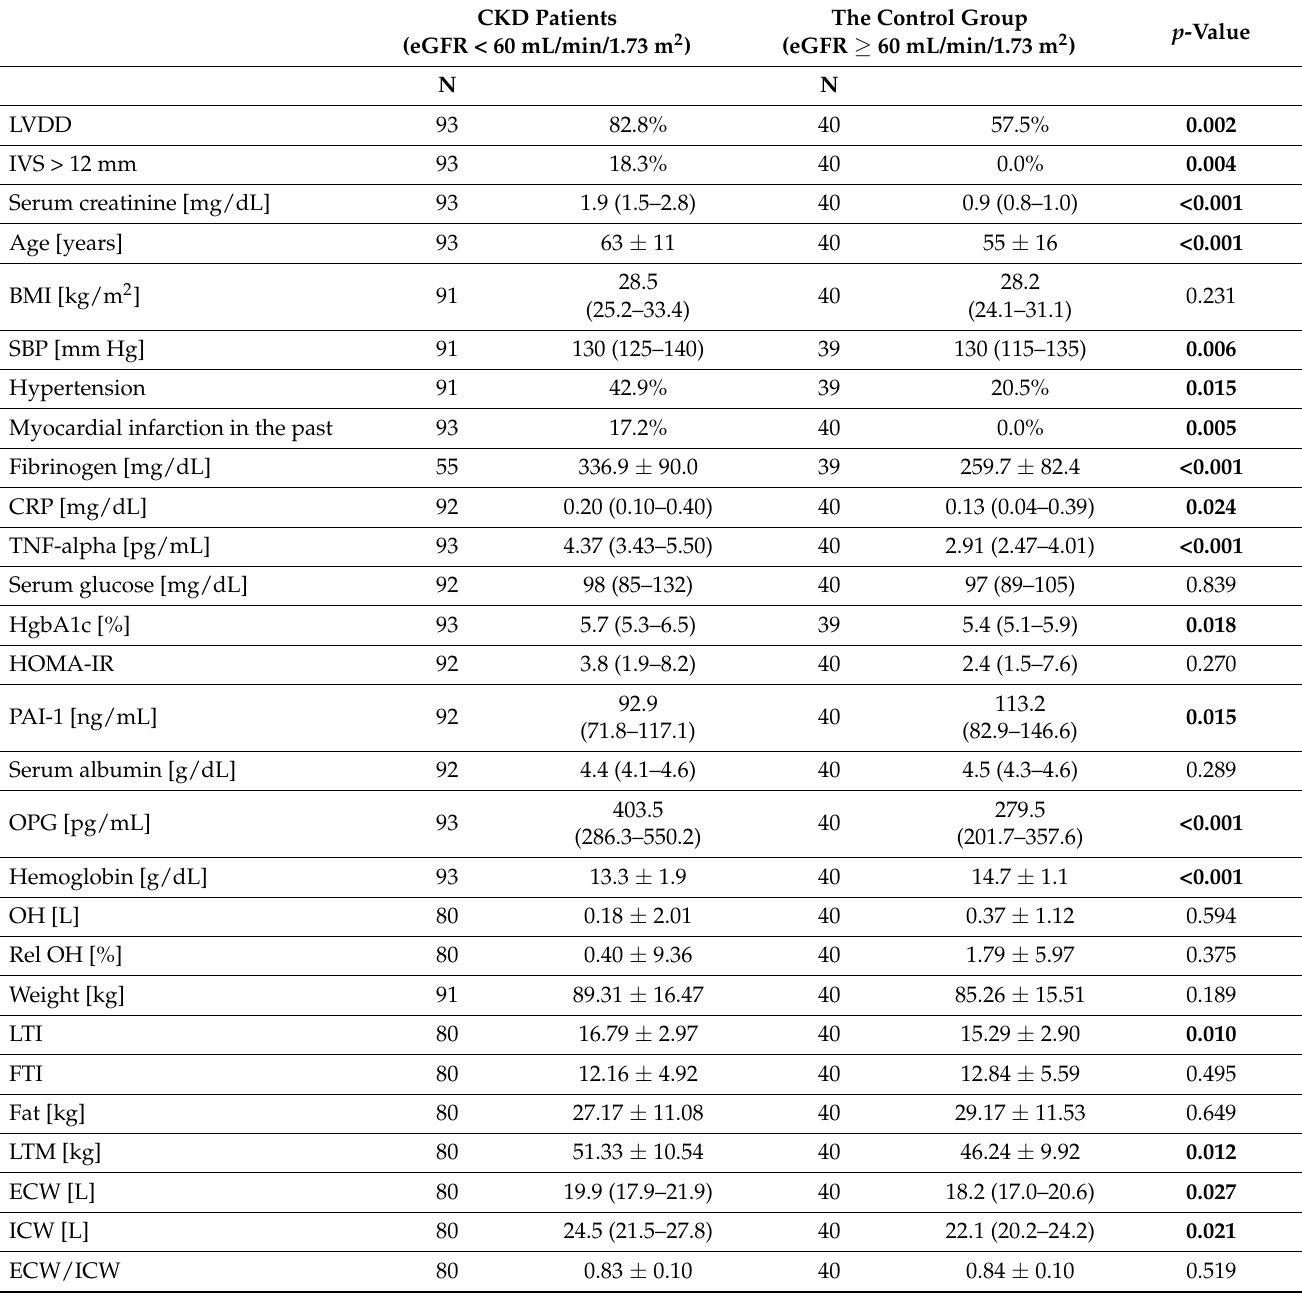
Table 1. Clinical data of the studied